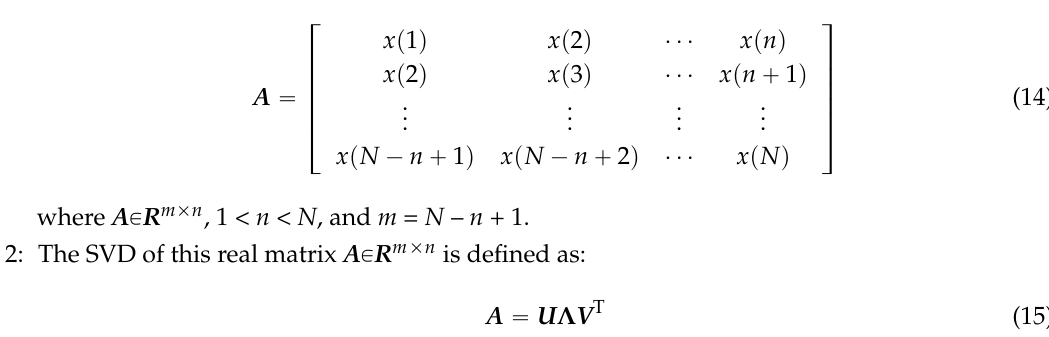
Figure 4. UHF PD signals with suppressed periodic narrowband noise: ( a ) in time domain; ( b ) in time-frequency domain.